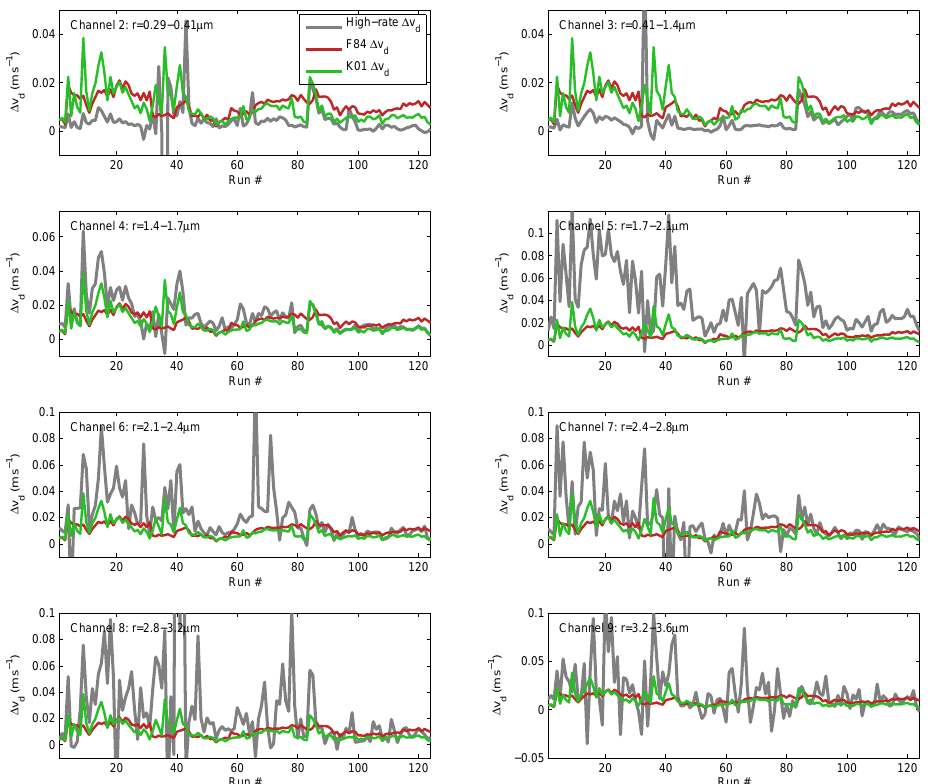
Fig. 6. Apparent deposition velocity due to hygroscopicity, 1v d , calculated through K01’s and F84’s methods, and the difference in the high-rate deposition velocity between ambient and RH-corrected (to run mean) spectra. CLASP channels 2–9 are